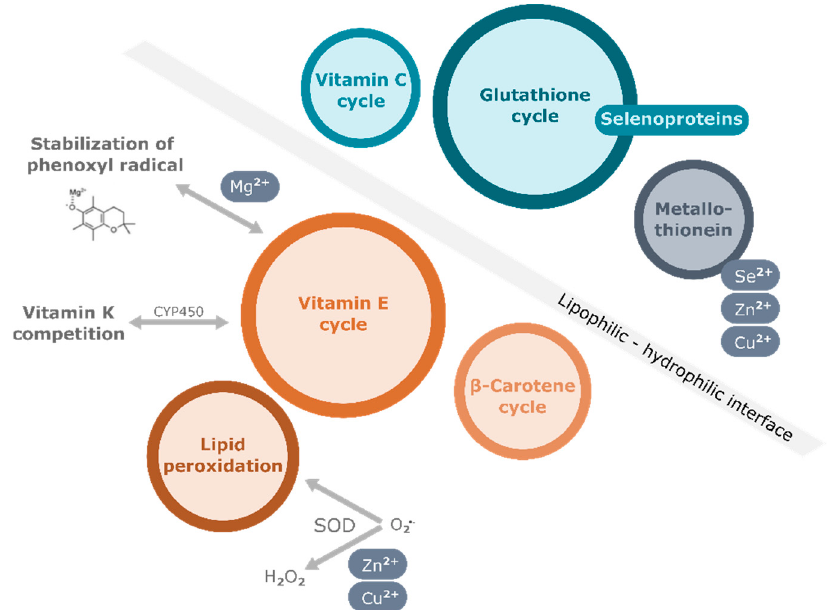
Figure 1. Possible mechanisms underlying the interaction between vitamin E and other micronu- trients. Free radicals such as O 2 • − (hyperoxide anion) attack the double bonds of the unsaturated fatty acids of membrane phospholipids resulting in the formation of a lipid peroxyl radical (RO 2• ). Vitamin E (TOHs and T3s) provides its phenolic hydrogen atom to the peroxyl radical and converts it to a hydroperoxide. The resulting vitamin E radical can be reduced by: Vitamin C which forms then an ascorbyl radical which is regenerated with the help of glutathione (GSH). In this process, two monomers of GSH are oxidized to form a dimer (GSSG). Selenoproteins and the metal ion transporter metallothionein are involve in reducing GSSG to GSH. Pro-vitamin A ( β -carotene) regenerates TOH from tocopheryl radicals. The resulting carotenoid radical cation is further regenerated by the vitamin C cycle. Besides that, magnesium ions contribute to the stabilization of the vitamin E radical and vitamin K competes hypothetically with vitamin E for the enzyme CYP4F2 which ω -hydroxylates the side-chains of both vitamin K 1 (phylloquinone) and vitamin E. Abbreviations: CYP, cytochrome P450; SOD, superoxide